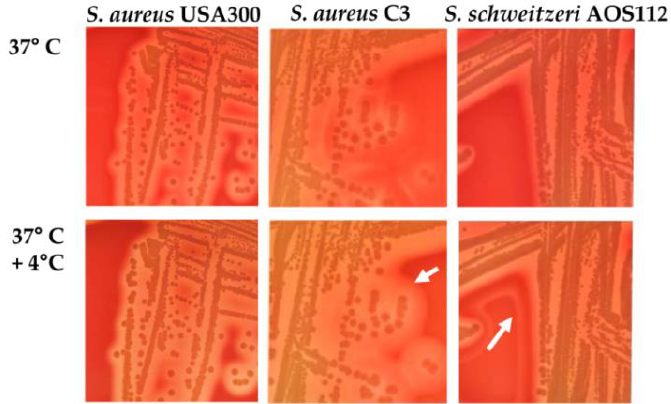
Figure 1. Hemolysis of Staphylococcus aureus USA300, S. aureus C3, and Staphylococcus schweitzeri AOS112. Cultivation on Columbia blood agar at 37 °C overnight, followed by cooling to 4 °C for 24 h results in an enhanced hemolysis pattern plates only with S. aureus C3 (animal adapted goat isolate with intact hlb gene [35] ) and S. schweitzeri AOS112 [31] (arrows indicate double hemolysis) but not with the human-adapted S. aureus USA300 [36] (digital photos for this review article were taken after incubation at 37 °C and after further incubation at 4 °C).